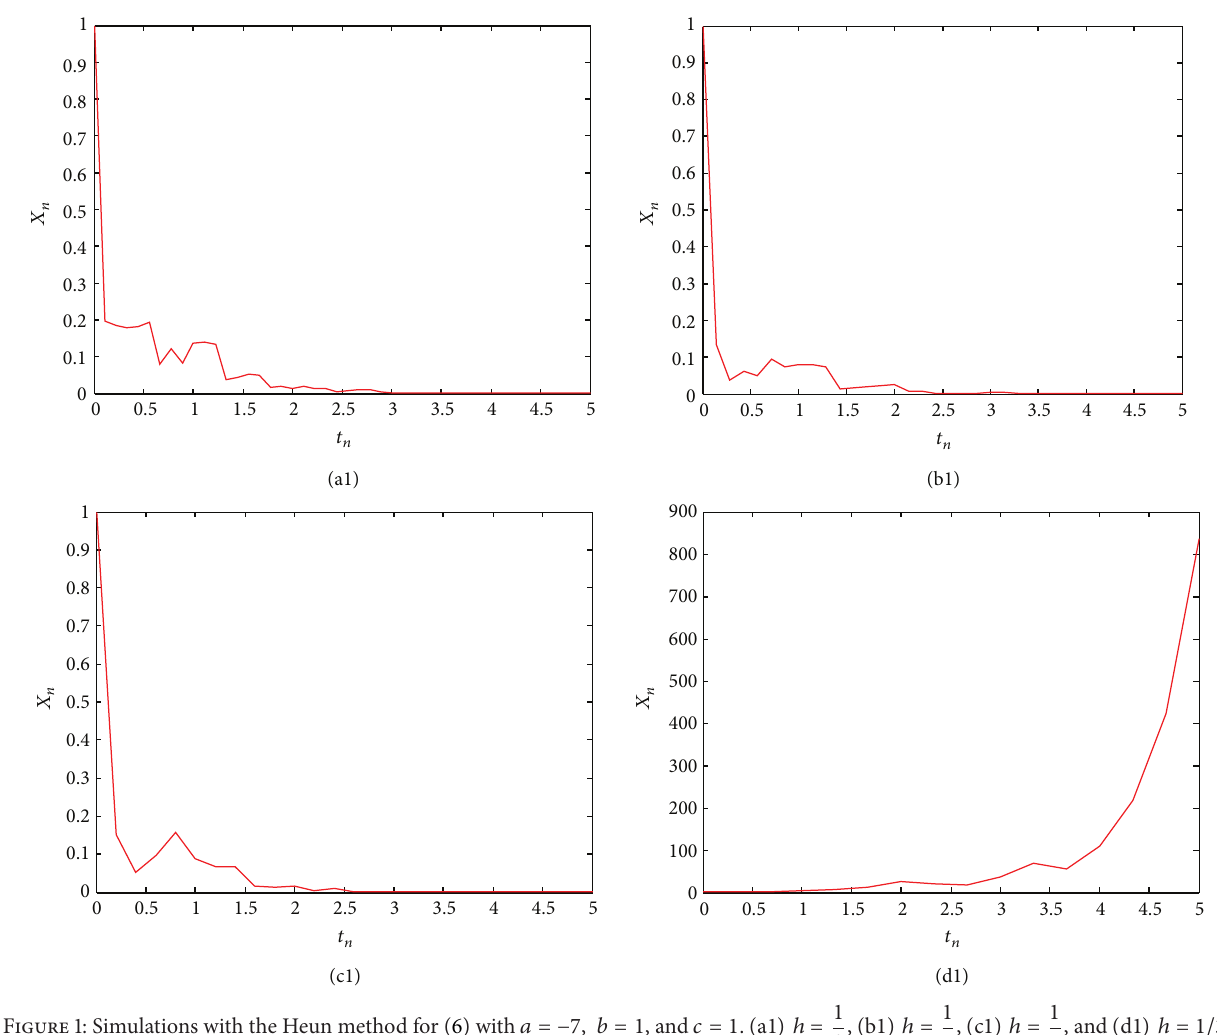
Figure 1: Simulations with the Heun method for (6) with 𝑎 = −7, 𝑏 = 1 , and 𝑐 = 1 . ( a 1) ℎ =